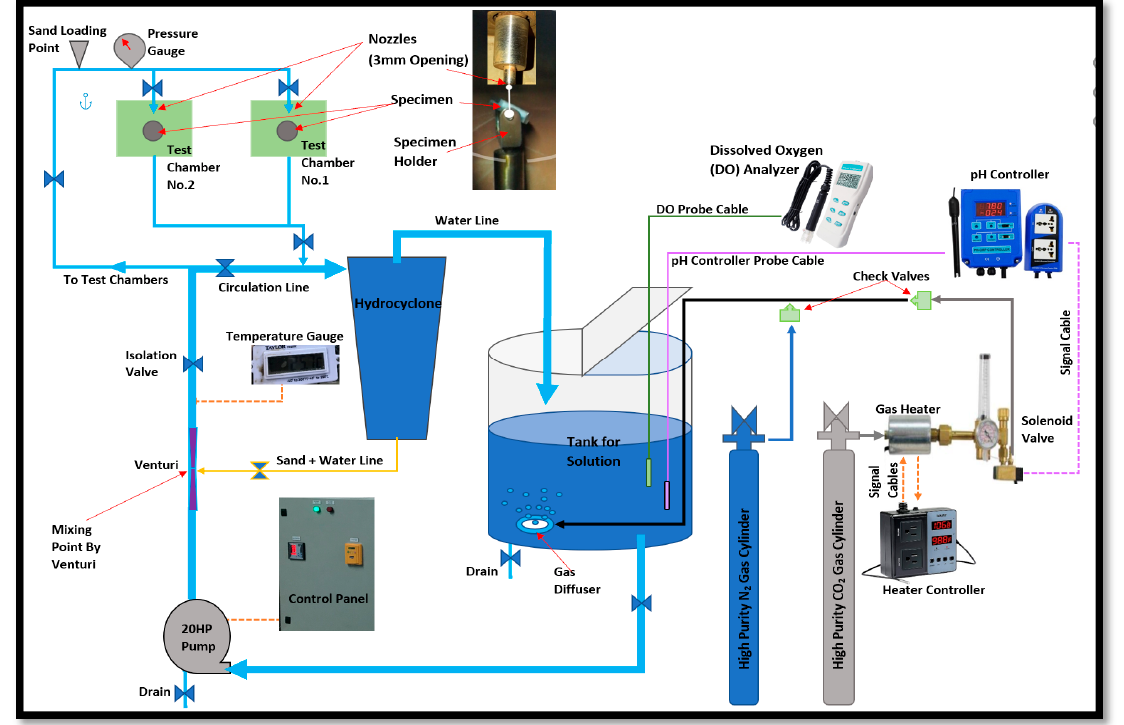
Figure 1. Sketch for CO 2 erosion–corrosion Flow Loop.